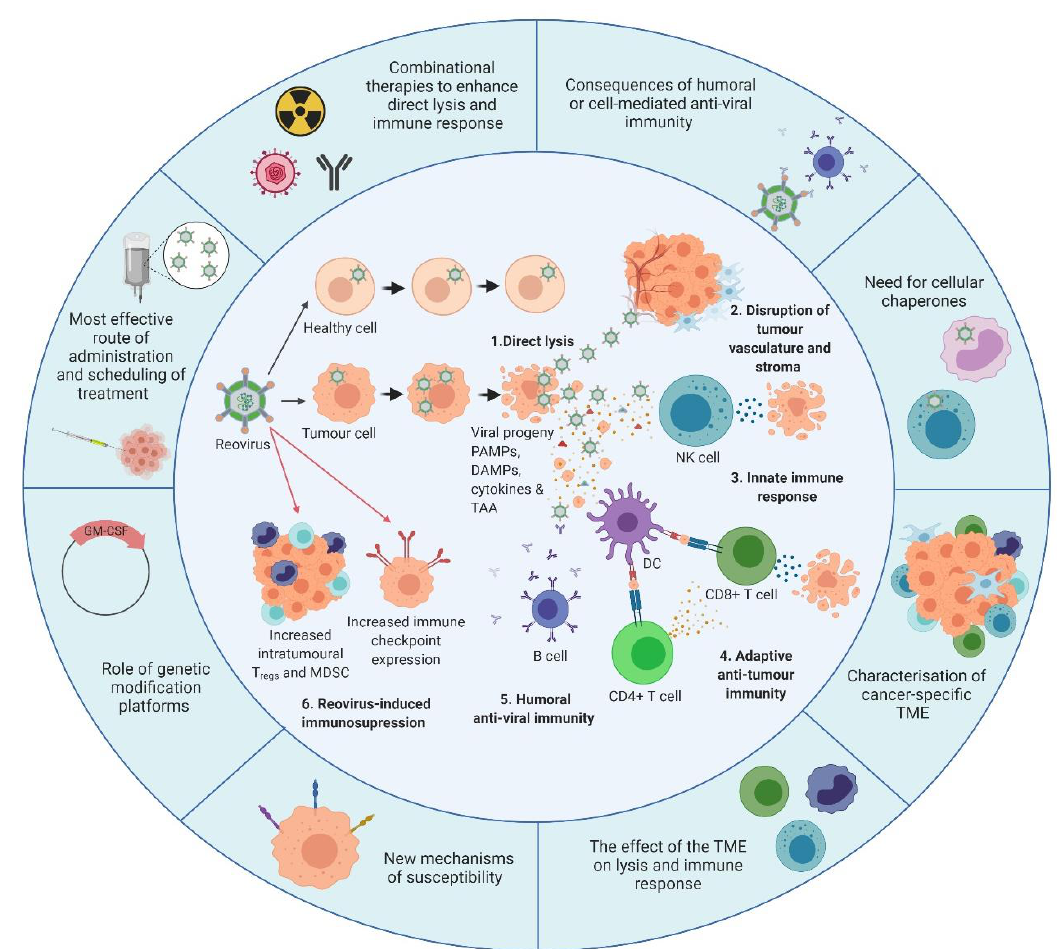
Figure 2. Overview of reovirus mechanisms of action and the developments required. The inner circle illustrates what is currently known about reovirus. 1. In healthy cells, anti-viral immune responses limit reovirus replication and prevent lytic killing. By contrast, oncogenic signalling pathways render tumour cells susceptible to reovirus replication and direct oncolysis. 2. Reovirus replicates in the tumour vasculature and stroma due to reciprocal cell:cell interactions which alter anti-viral signalling. 3. Infection of tumour cells leads to the release of viral progeny, cytokines and tumour-associated antigens (TAAs), which initiates innate anti-tumour immunity including cytokine-mediated bystander killing and natural killer (NK) cell-mediated cytotoxicity. 4. Adaptive anti-tumour immunity is generated following the phagocytosis of TAAs by dendritic cells (DCs) and presentation of TAAs to CD4 + ve and CD8 + ve T cells, which facilitates priming of tumour-specific cytotoxic T lymphocytes (CTLs). 5. In addition to innate and adaptive anti-tumour immune responses, humoral anti-viral immunity is induced, leading to the production of reovirus-specific neutralising antibodies (NAbs). 6. Following induction of anti-tumour / anti-viral immune responses, regulatory immune mechanisms are “switched-on” to control ongoing immune responses, including upregulation of immune checkpoints and increased levels of regulatory T cells (T regs ) and / or myeloid-derived suppressor cells (MDSCs). The outer circle highlights priority research areas to improve reovirus e ffi cacy. These include gaining a greater understanding of: (i) the consequence of humoral and / or cell-mediated anti-viral immunity on reovirus e ffi cacy which would inform the development of, or the requirement for, cellular chaperones; (ii) the tumour microenvironment (TME) and how it influences reovirus oncolysis and anti-tumour immunity; (iii) the cellular determinants utilized by reovirus for direct oncolysis, including mechanisms of reovirus resistance; (iv) the potential benefits of genetically-modified reovirus platforms; (v) reovirus scheduling to maximize virus delivery and e ffi cacy including the best route of virus administration; and (vi) combinatorial approaches that are designed to boost both direct oncolysis and anti-tumour immune responses. PAMPs: pathogen-associated molecular patterns; DAMPs: damage-associated molecular patterns; GM-CSF: granulocyte-macrophage colony stimulating factor. Figure created using